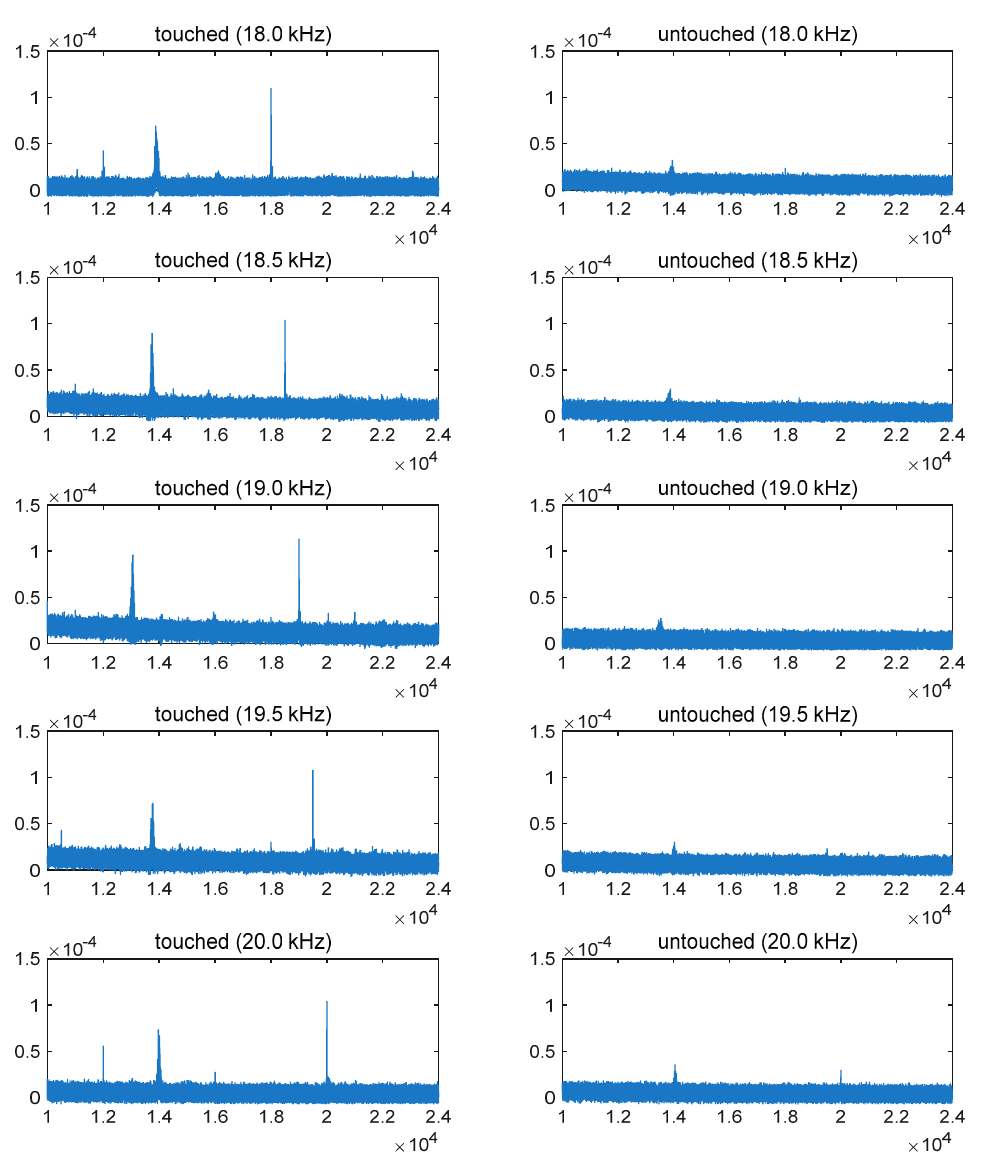
Figure 5. FFT analysis of the measured signals transferred from the